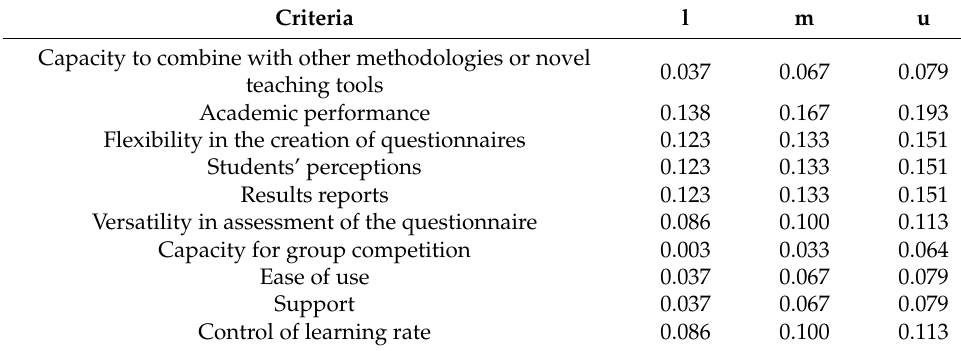
Table 4. Weightings of the criteria obtained via the MACBETH approach in the form of triangular fuzzy numbers. Criteria l m u Capacity to combine with other methodologies or novel teaching tools Flexibility in the creation of